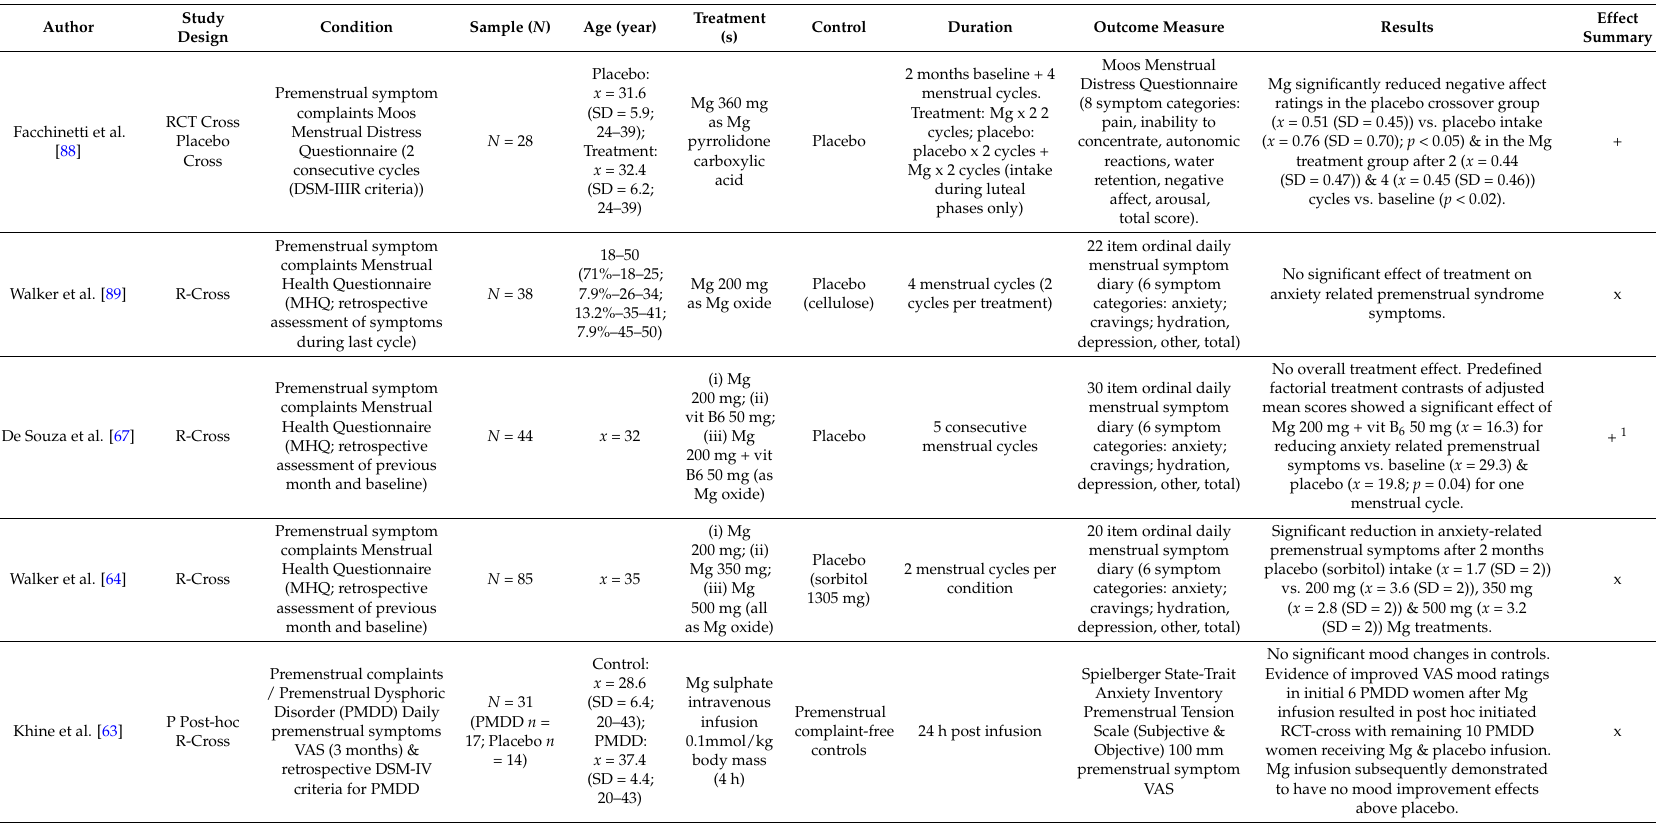
Table 2. Summary of studies reporting the effects of Mg on subjective anxiety/stress in individuals reporting premenstrual syndrome